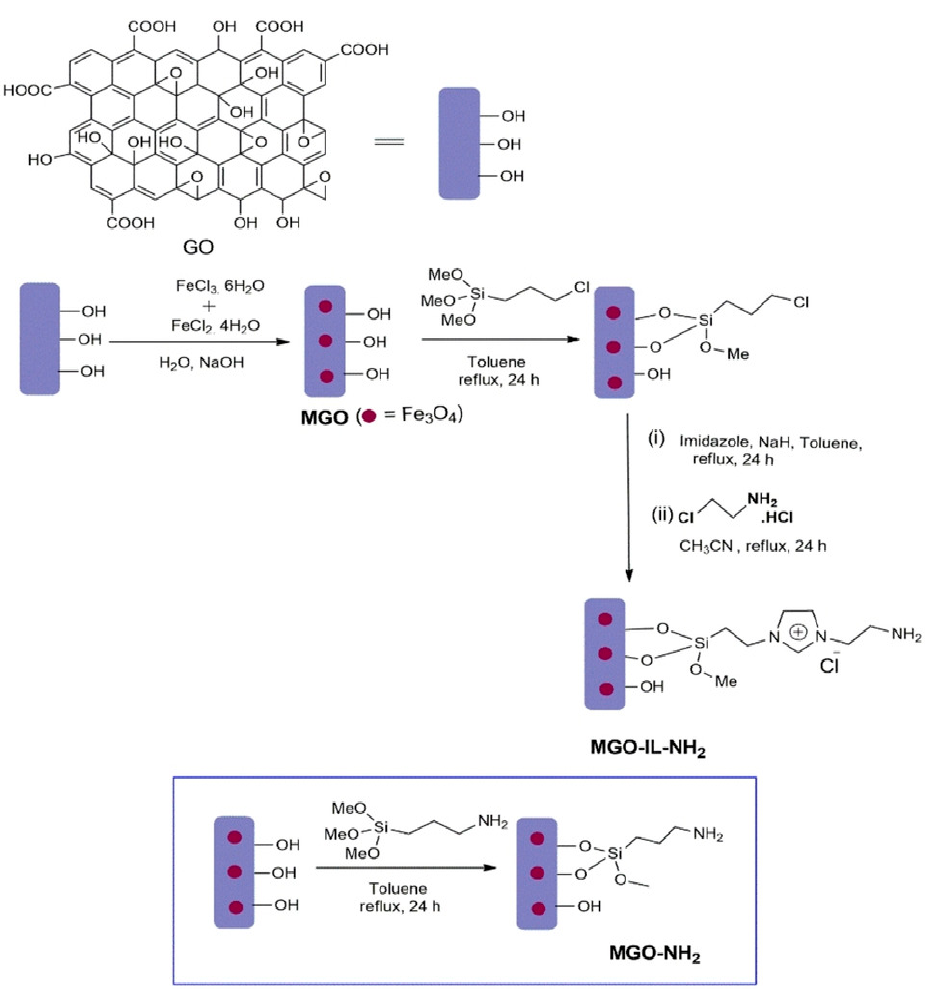
Figure 1. Schematic diagram for the preparation of magnetic graphene oxide-supported IL (MGO − IL − NH 2 ).